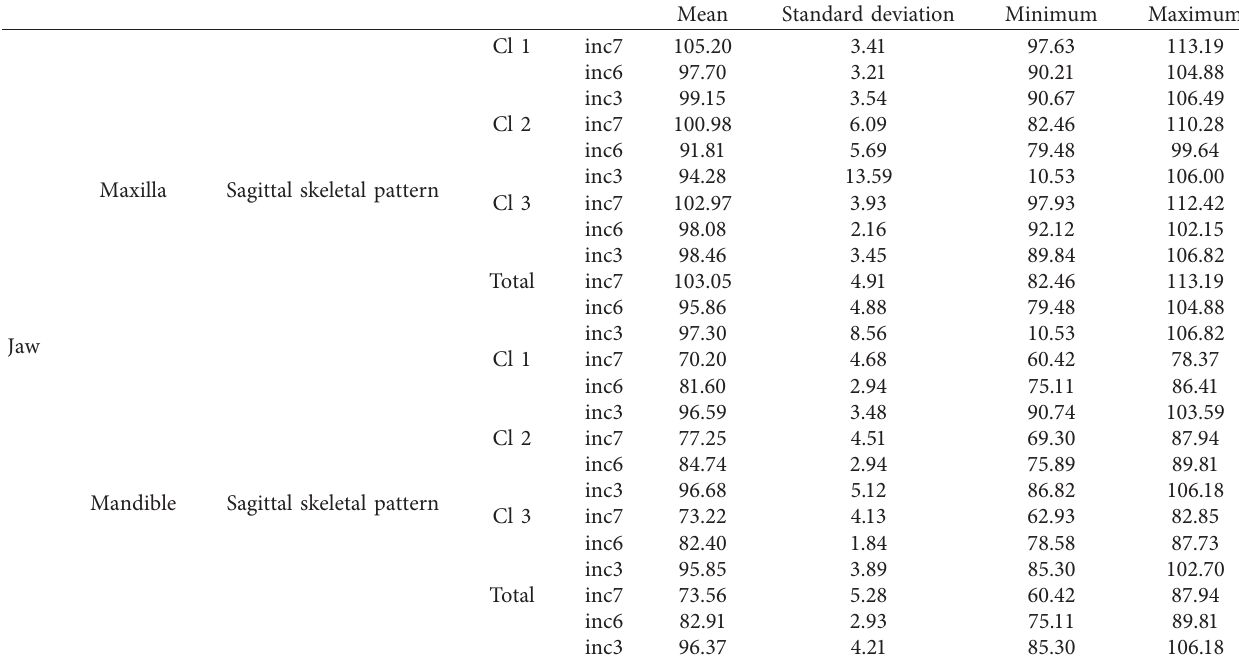
Table 4: Mean inclination of teeth in the three sagittal skeletal patterns.